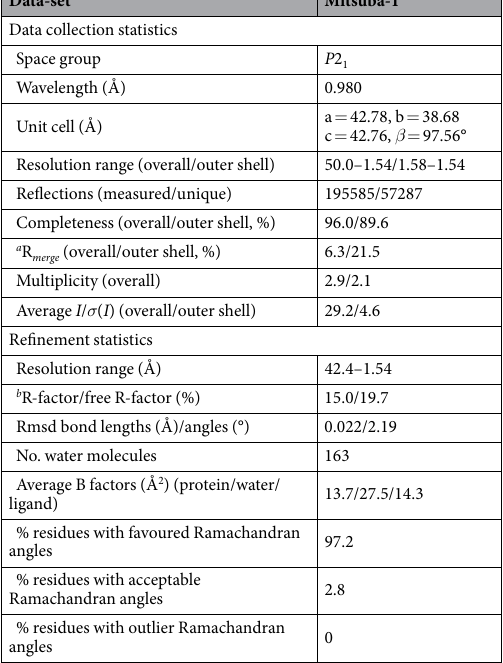
Figure 4B). Fitting the curves obtained to a two-state model yielded denaturation mid-points at GdnHCl con- centrations of 3.6 M and 1.3 M for Mitsuba-1 and MytiLec-1 respectively. MytiLec-1 is a tightly-bound dimer, as shown in Fig. 1C, but the interface of the natural protein is not preserved in Mitsuba-1.